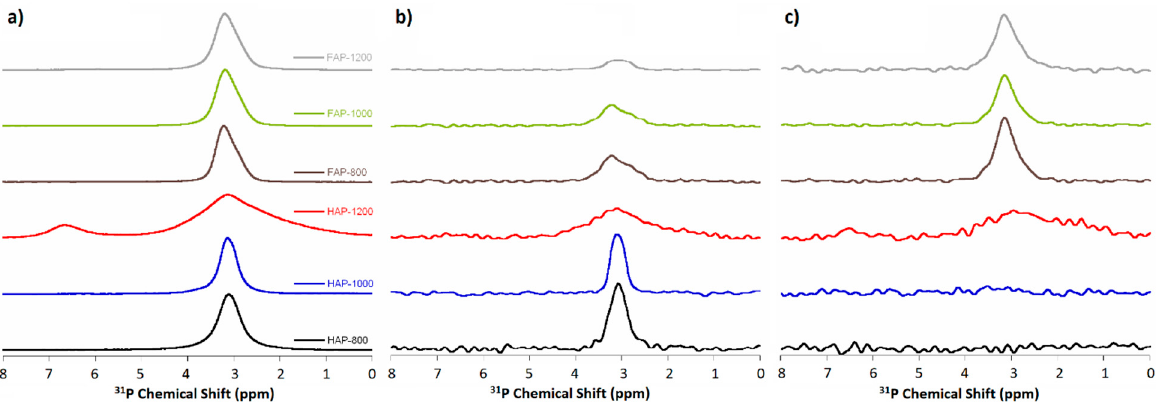
Figure 8. NMR spectra of ( a ) 31 P BD MAS NMR; ( b ) 1 H → 31 P CP MAS NMR; and ( c ) 19 F → 31 P CP MAS NMR.